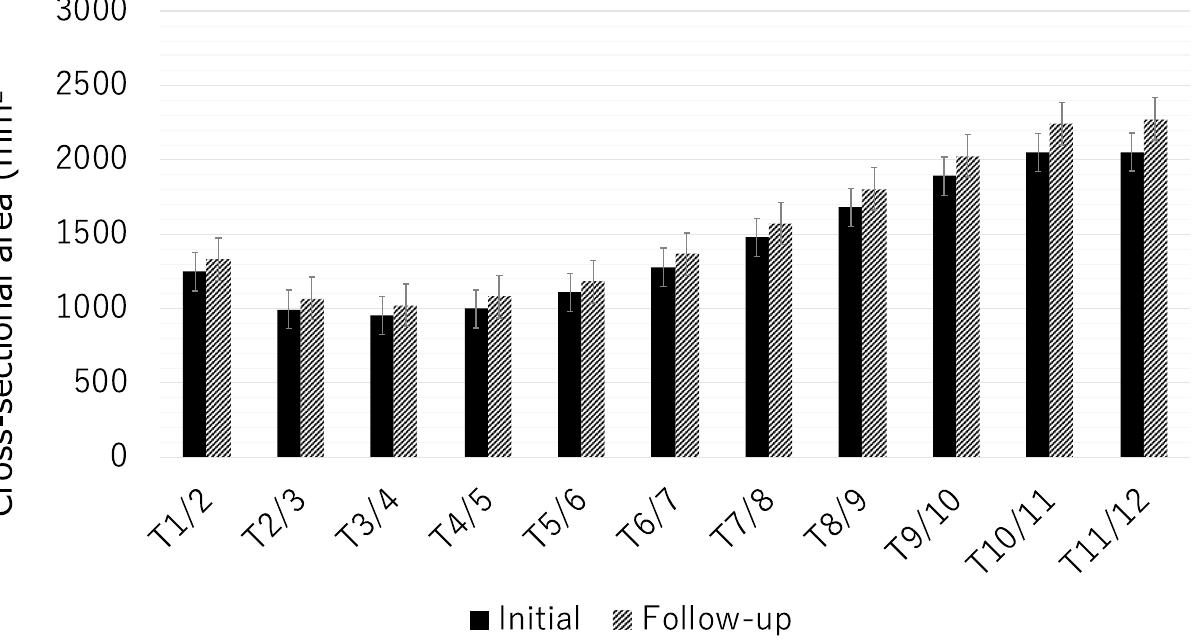
Figure 3. The cross-sectional areas of the total posterior extensor muscles at each intervertebral disc level. The cross-sectional areas of the total posterior extensor muscles significantly increased over 10 years at all levels from T1/2 to